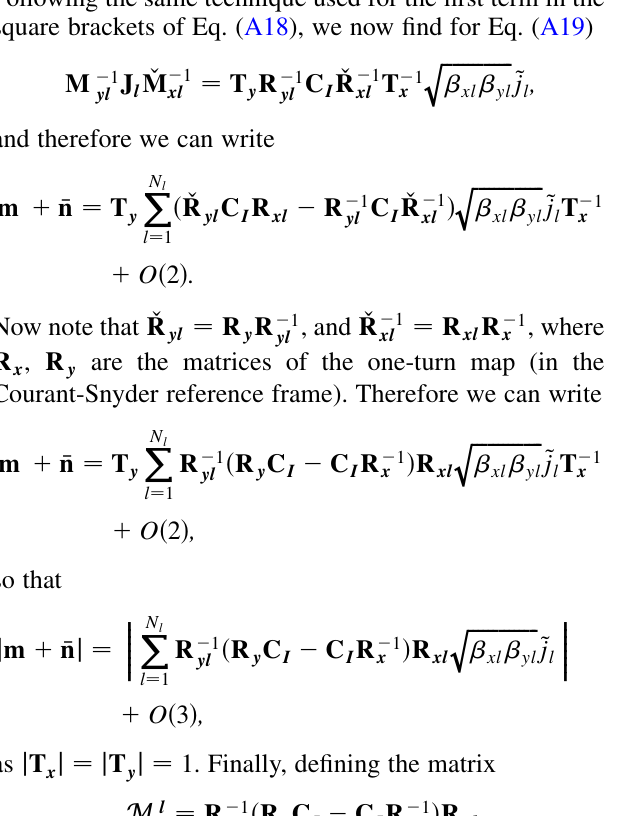
ffiffiffiffiffiffiffiffiffiffiffiffiffiffiffiffiffiffiffiffiffiffiffiffiffiffiffiffiffi p (cid:3) (cid:3) (cid:3) (cid:3) xl yl xq yq